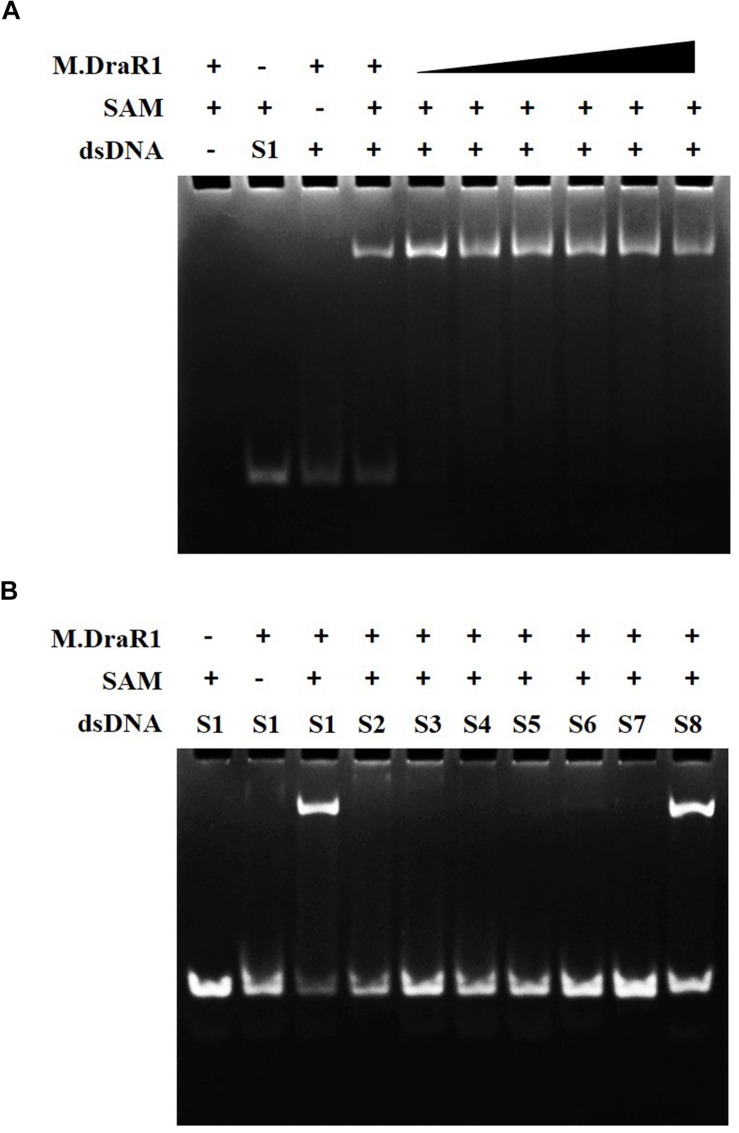
EMSA analysis of DNA binding by M.DraR1. (A) M.DraR1 binding oligonucleotide cassettes (annealed by S1-F and S1-R oligonucleotides in Supplementary Table S2) containing a “CCGCGG” sequence with different concentrations (from 100 μM to 1 mM). Excess (0.5 mM) or none SAM were added in binding buffer (20 mM Tris–HCl pH 8.0, 100 mM KCl, 7 mM β-Me, 0.1mM EDTA and 0.1 mg/mL BSA). (B) M.DraR1 could not bind oligonucleotides with site mutations in the “CCGCGG” sequence (Supplementary Table S2, from Supplementary Tables S2-S7 paired oligomers). Another blunt-ended dsDNA for “CCGCGG” was analyzed as well (last lane, S8 oligonucleotide cassette). The 100 μM double strand cassettes were used for each reaction. All the reactions were performed in three independent biological replicates.